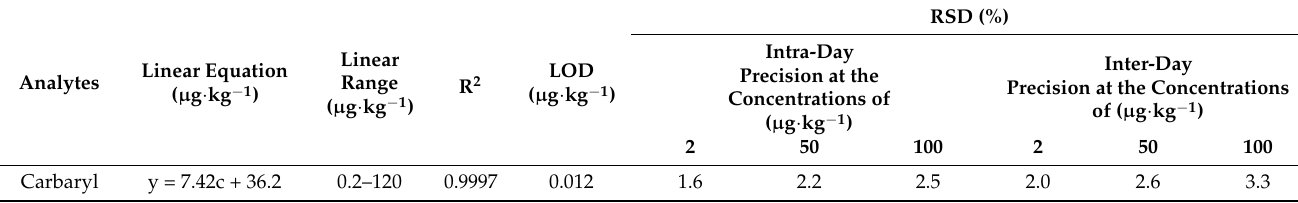
Table 2. Analytical performance and parameters of the